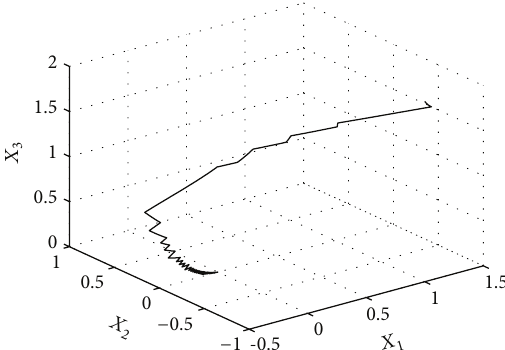
Figure 3: Phase plane trajectory of the three systems.